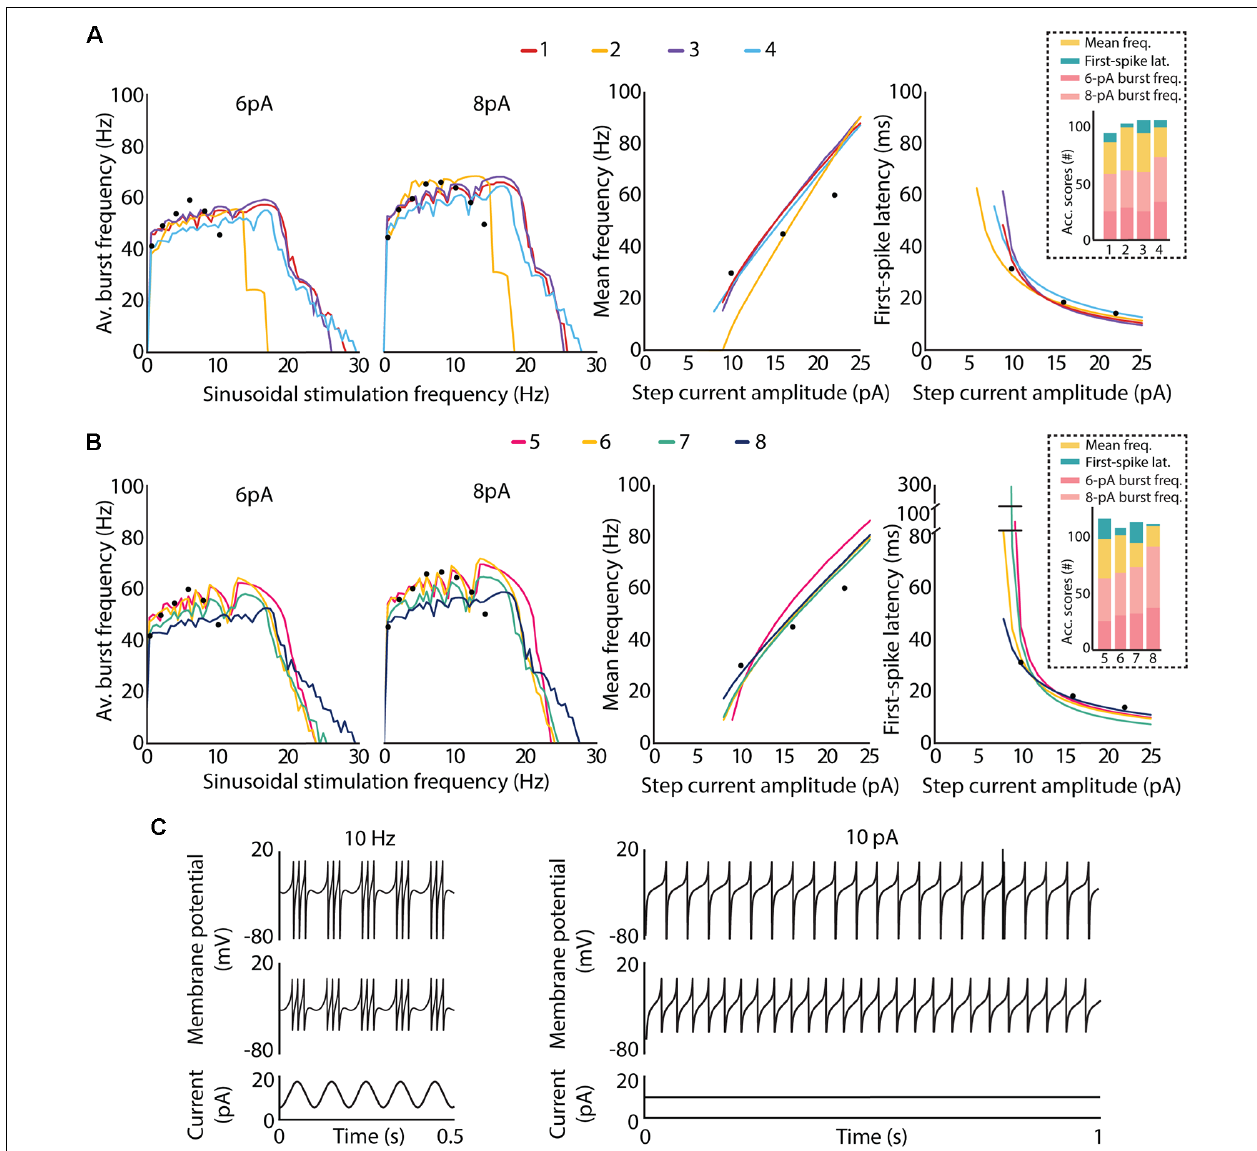
FIGURE 6 | Intrinsic excitability of the top-ranked neuron models of cerebellar GrCs. The optimal candidate solutions are qualitatively analyzed according to the features defined in the objective function, i.e., spiking resonance in the theta range under sinusoidal stimulation (left plots), mean frequency (middle plots) and latency to the first spike (right plots), the last two under direct current stimulation. Black dots represent the experimental data used as reference in the optimization process. (A) Spiking dynamics of the top-four candidate solutions of the final population. Their accumulated scores of each feature are represented as bars in the dashed box. (B) Spiking dynamics of the candidate solutions ranked 5–8 of the final population. Their accumulated scores for each feature are represented as bars in the dashed box. (C) Example traces from two of the best candidate solutions (top plots from candidate 5 and middle plots from candidate 6) show: on the left, spike bursts from both neurons under sinusoidal current injection of 10-Hz frequency, 6-pA amplitude and 12-pA offset, as it is represented in the bottom plot; on the right, repetitive spike discharge from both neurons during a step-current injection of 10 pA, which is represented in the bottom